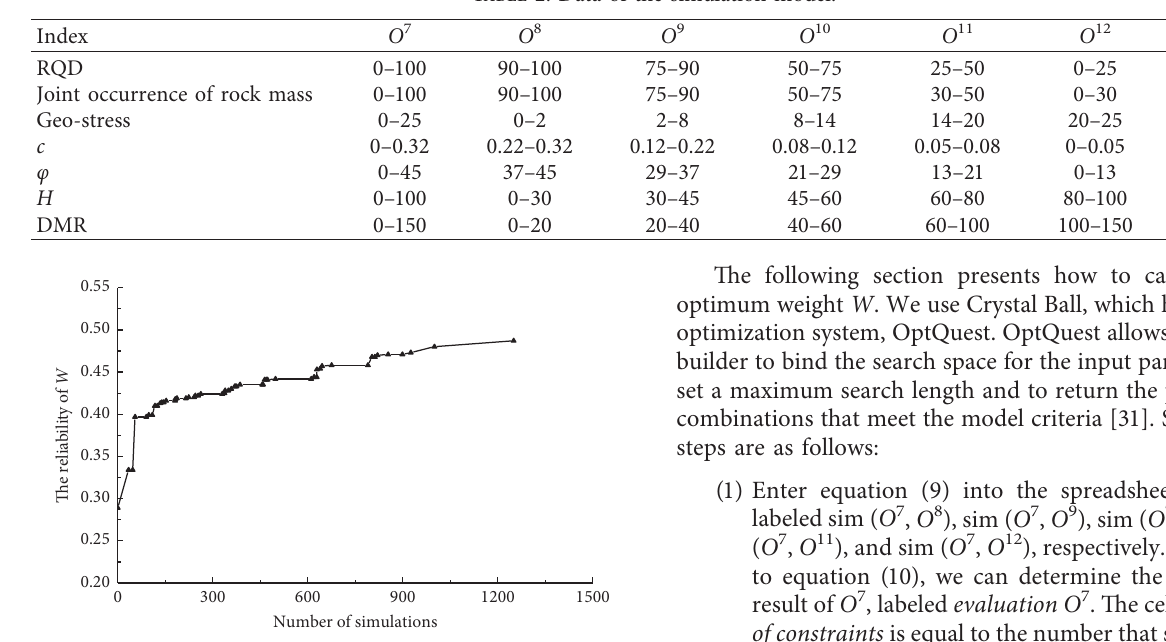
Figure 5: The reliability of W obtained at different number of